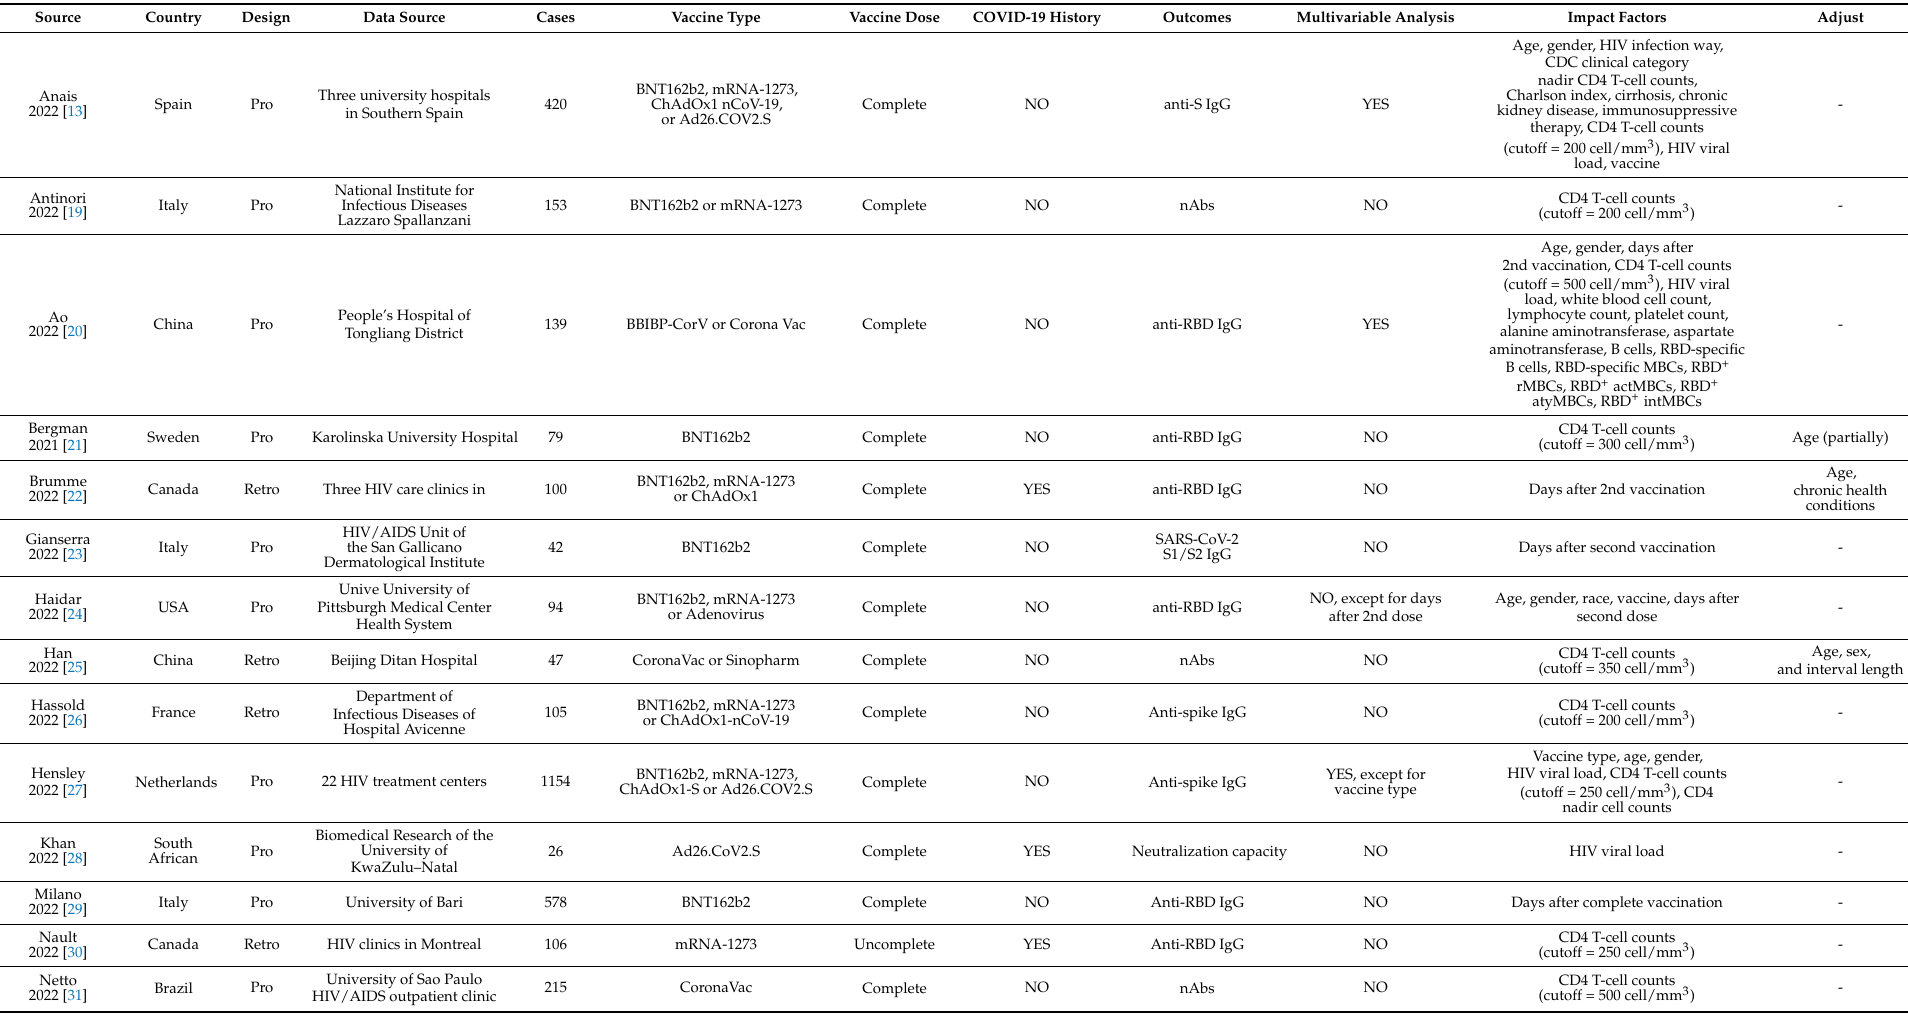
Table 1. Characteristics of included